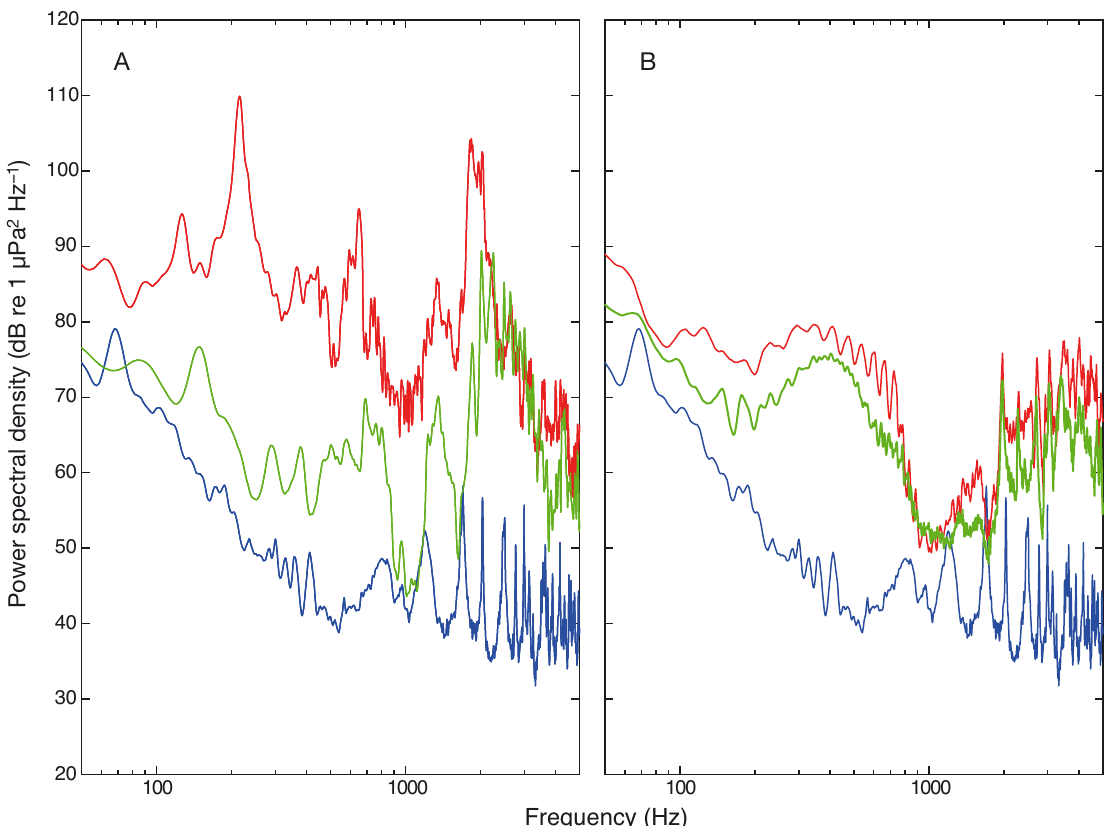
Fig. 1. Mean power spectral densities (dB re 1 µPa 2 Hz −1 ) for ambient sound (blue line), playback sound (red line) and source sound (green line) for (A) whiteleg shrimp Litopenaeus vannamei and (B) Atlantic salmon Salmo salar sound